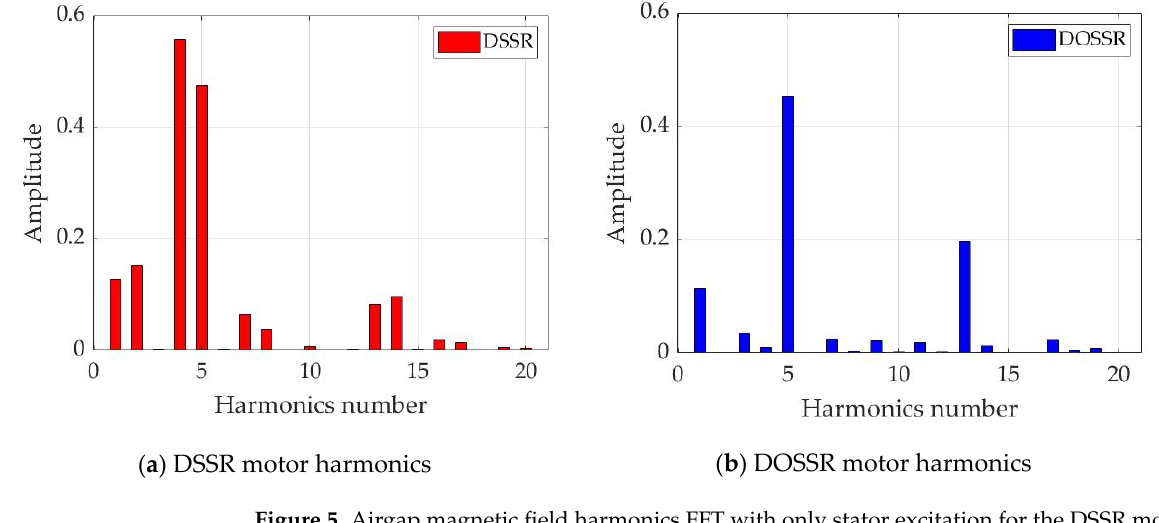
Figure 5. Airgap magnetic field harmonics FFT with only stator excitation for the DSSR motor and the DOSSR motor.